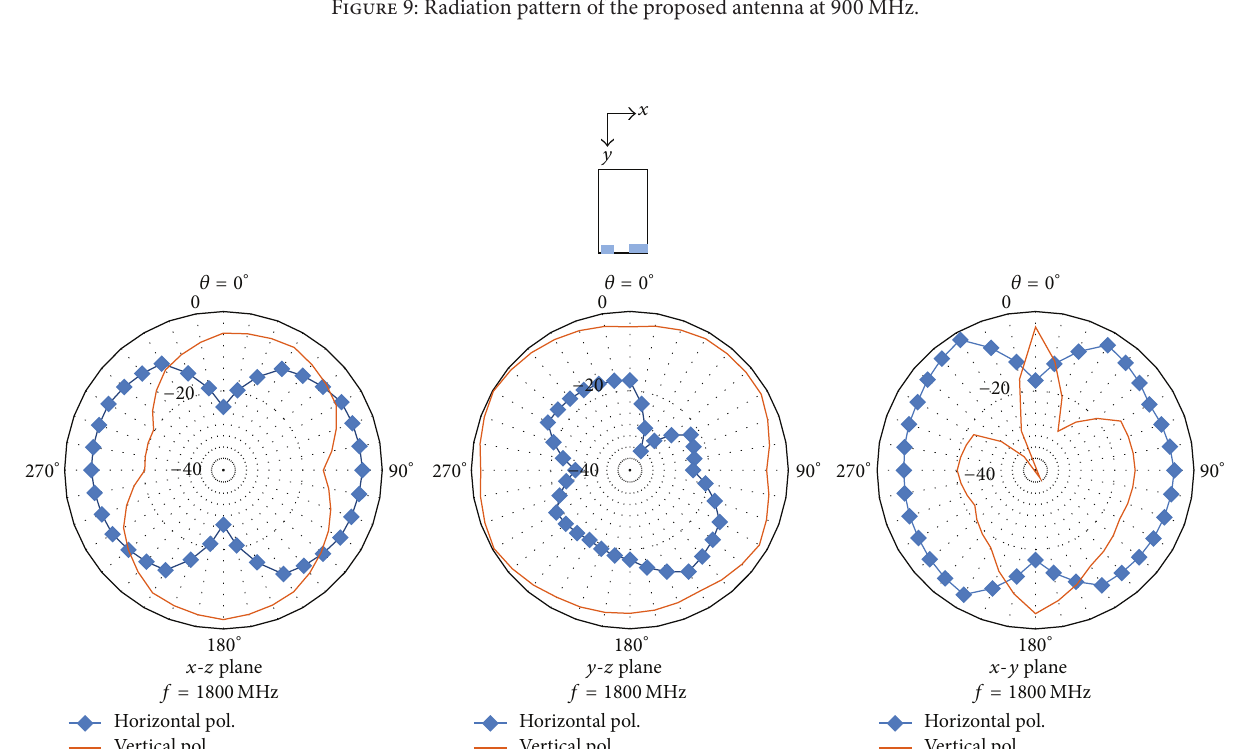
pol.Horizontal pol. Vertical